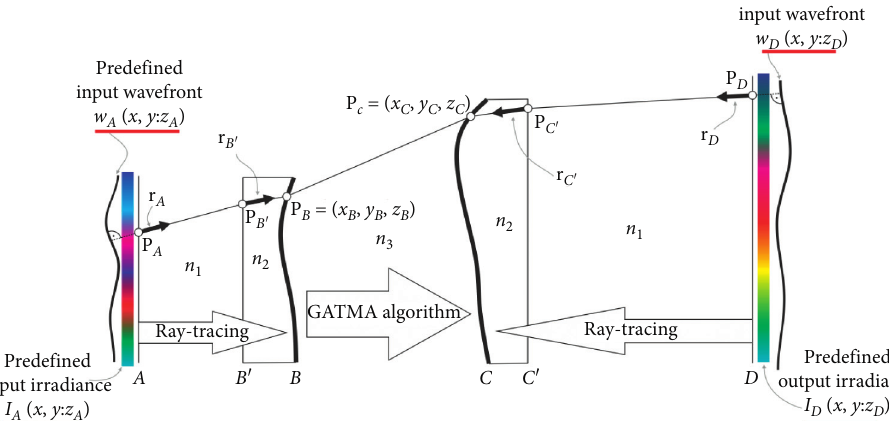
Figure 2: Setup and symbol definitions of the designed double plano-freeform lens beam shaper.